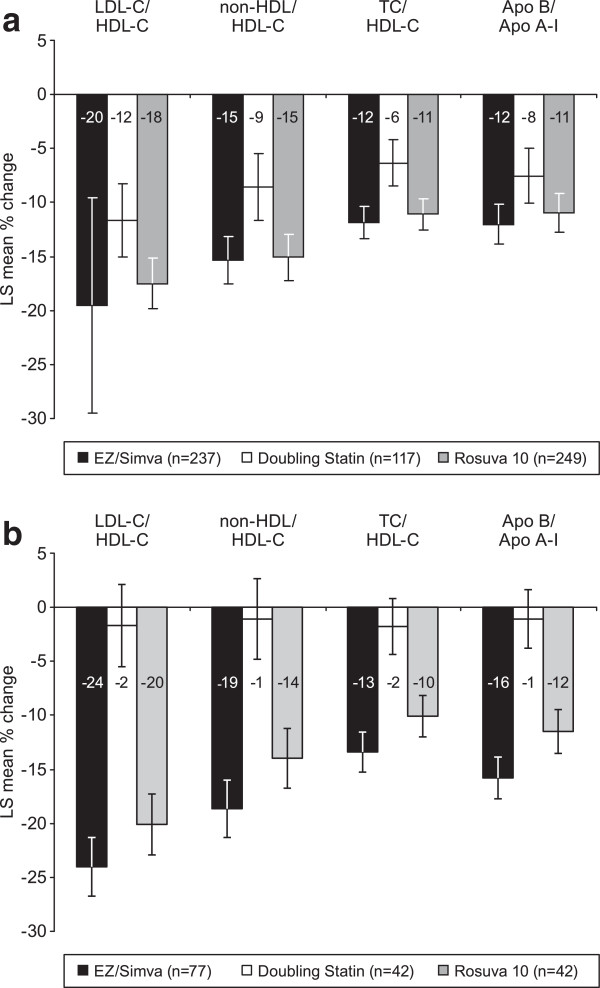
Least squares mean percent change from baseline in lipid ratios after 6 weeks of treatment. Bars represent standard error. (FAS population). a. obese subjects. b. non-obese subjects.